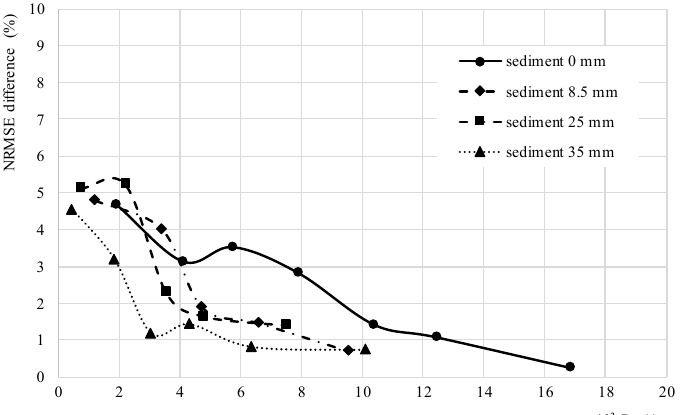
Figure 12. Difference of the normalised root mean square error (NRMSE) between the Gaussian approximation function according to Equation (3) and the GEV approximation according to Equation (5).